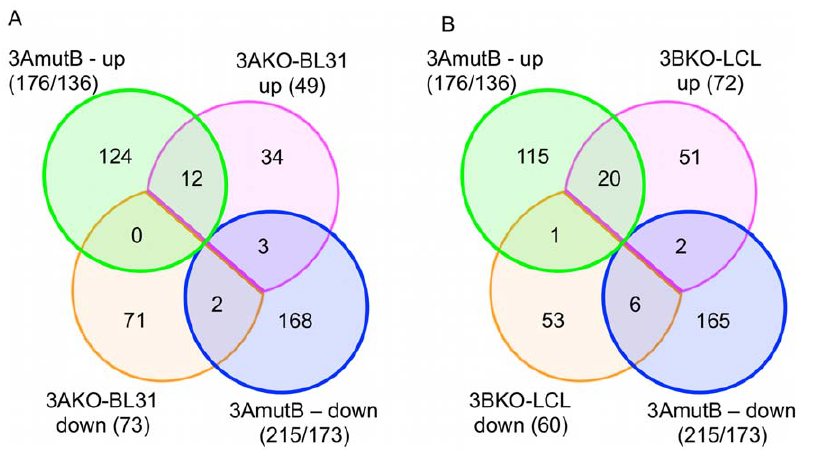
Figure 10. Consistency between 3AKO BL31 and LCLs, and co-operation between EBNA3B and EBNA3A in LCLs. Venn diagrams indicate overlap between genes differentially regulated [i.e. with a minimum fold change of 2 and p , 0.001] in ( A ) 3AmutB LCLs and 3AKO BL31; and ( B ) 3AmutB and 3BKO LCLs. Numbers of genes are indicated in the sets and the size of each set indicated below the set name. For 3AmutB this is denoted as ‘‘(no of probesets/no of unique gene IDs)’’. The 3AKO-BL31 and 3BKO-LCL sets exclude genes not represented in the U133 Plus2 microarray that was used to generate the 3AmutB LCL data.